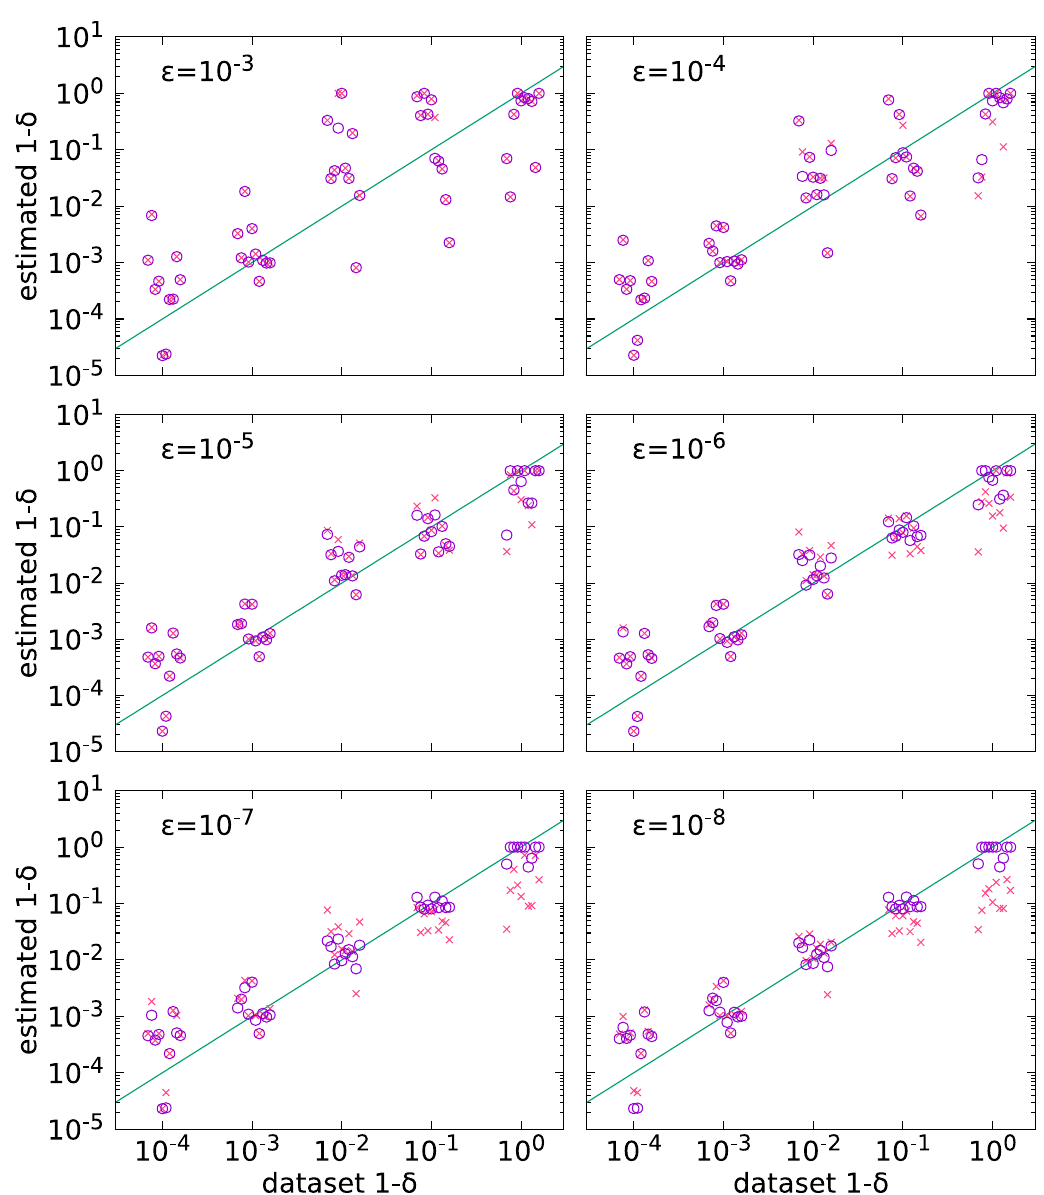
Fig 4. The effect of varying the error rate. Sequencing error rates are shown in the subplots. 10 4 trees with 10 4 leaves were used for fitting. Horizontal coordinates are slightly dispersed for clarity. Open circles are results corresponding to error rates fixed to their true values, crosses correspond to error rates estimated by the parameter fit. Each open circle-cross pair corresponding to the same dataset is vertically aligned. Note that the death rate decreases along the horizontal axis.